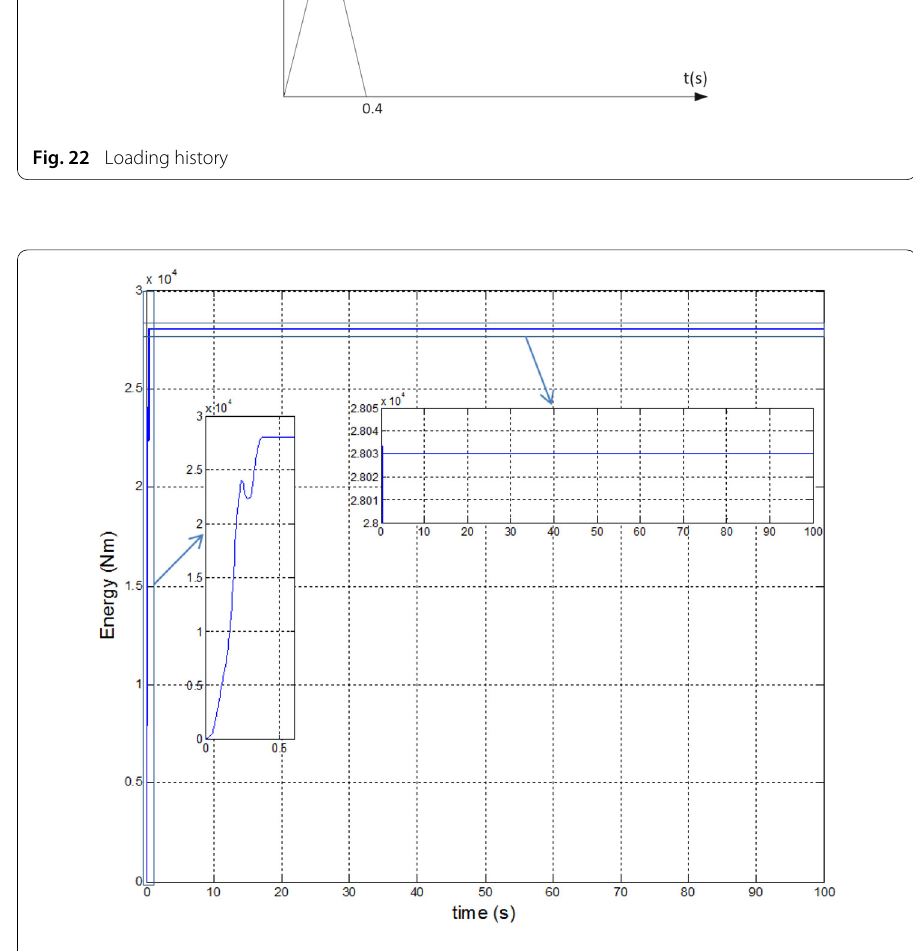
subjected to an externally applied moment acting at the beam end cross-section connected to the pinned support. As a consequence of the loading, the beam rotates about the out- of-plane axis and the mechanism converts a rotary motion to a straight-line motion. The flexible beam element parameters are given below and the loading history is shown in Fig. 29. Parameters: Beam length L 1 = 3 m , L 2 = 10 m, Height H = 2 m Cross section area A = 0 . 3 m 2 , Cross section inertia I = 0 . 0022 m 4 Young’s Modulus E = 200 GPa, Density ρ = 7850 kg/m 3 Number of elements = 6, Time increment (cid:15) t = 10 − 4 s Number of steps = 10